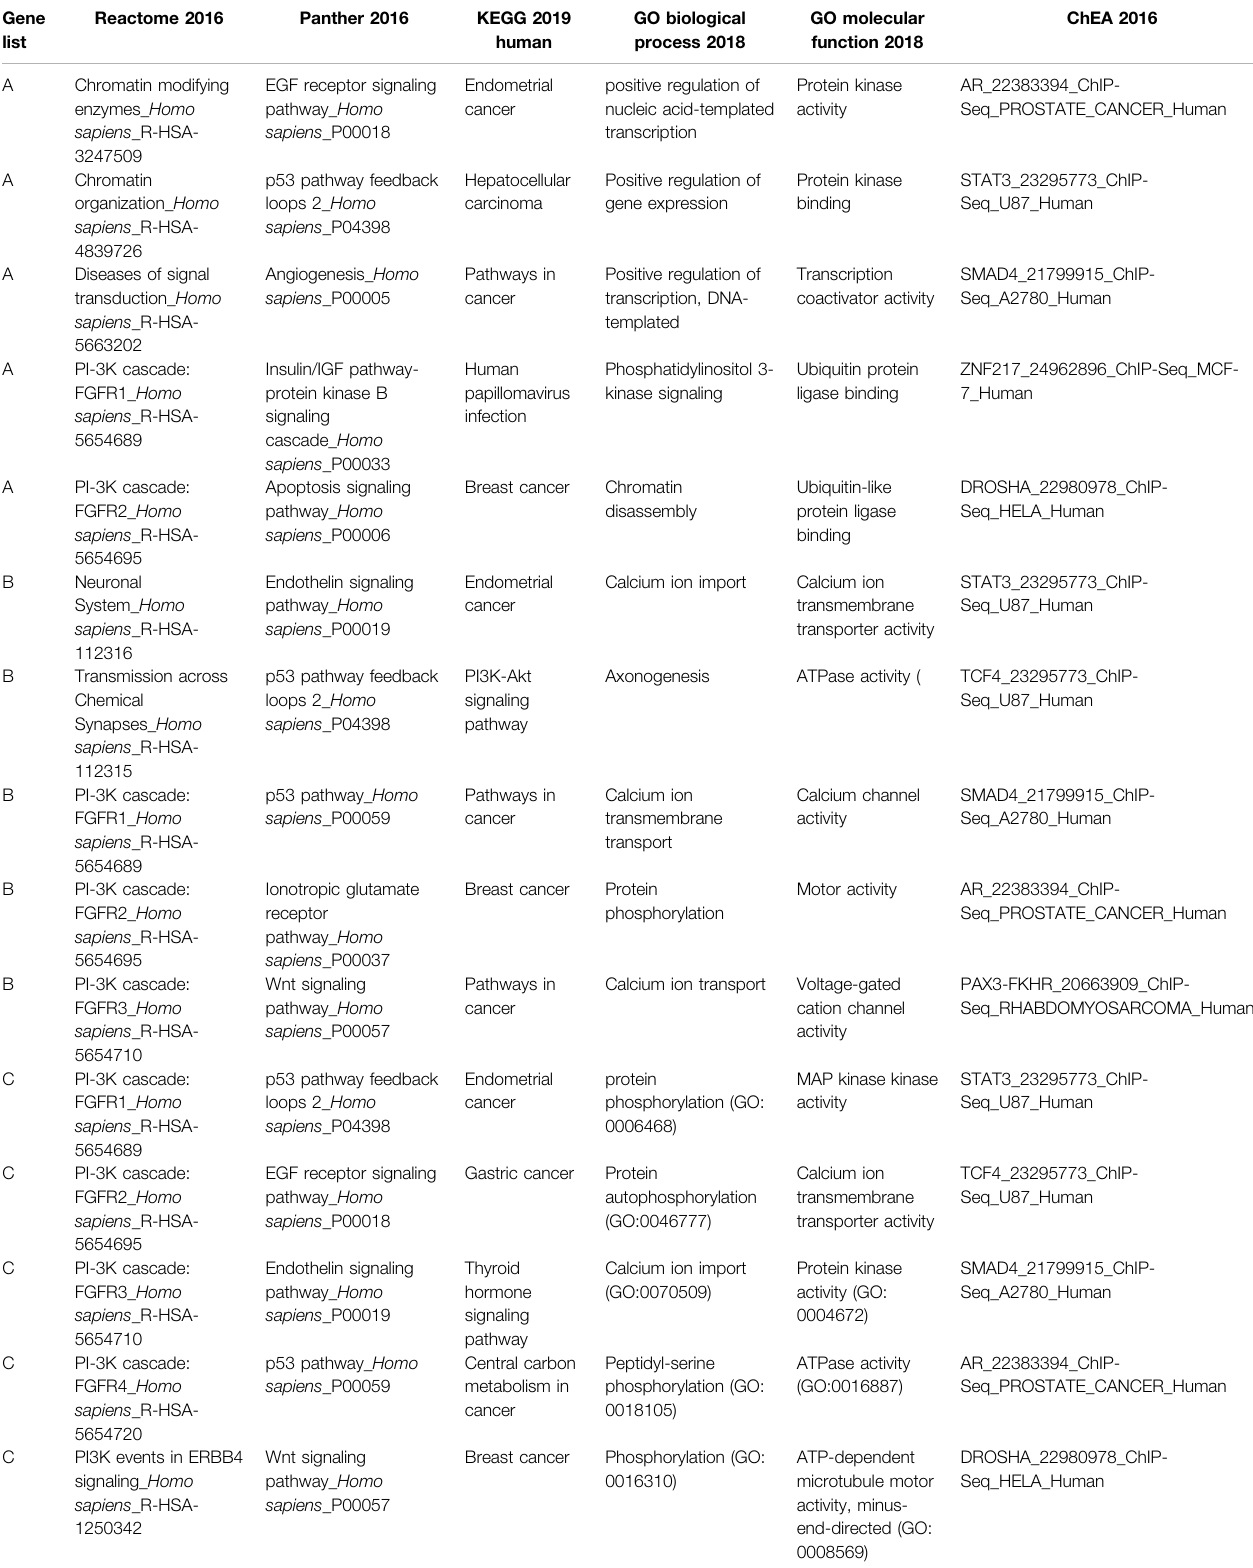
TABLE 5 | Signi fi cant (adjusted p -value < 0.05) gene sets showing an overrepresentation of our candidate gene lists. For each library we have only reported the fi ve top signi fi cant gene